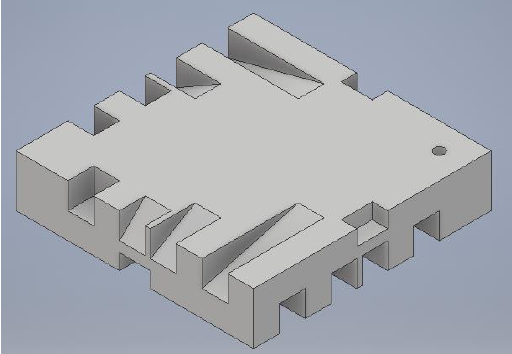
Figure 2. CAD model of a test sample (10 mm × 46 mm × 46 mm).